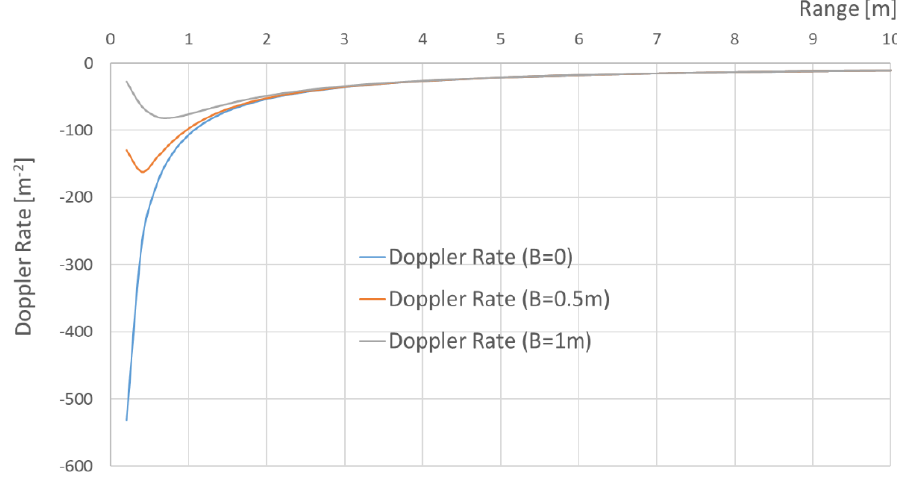
Figure 3. Doppler rate as a function of range with different baselines B